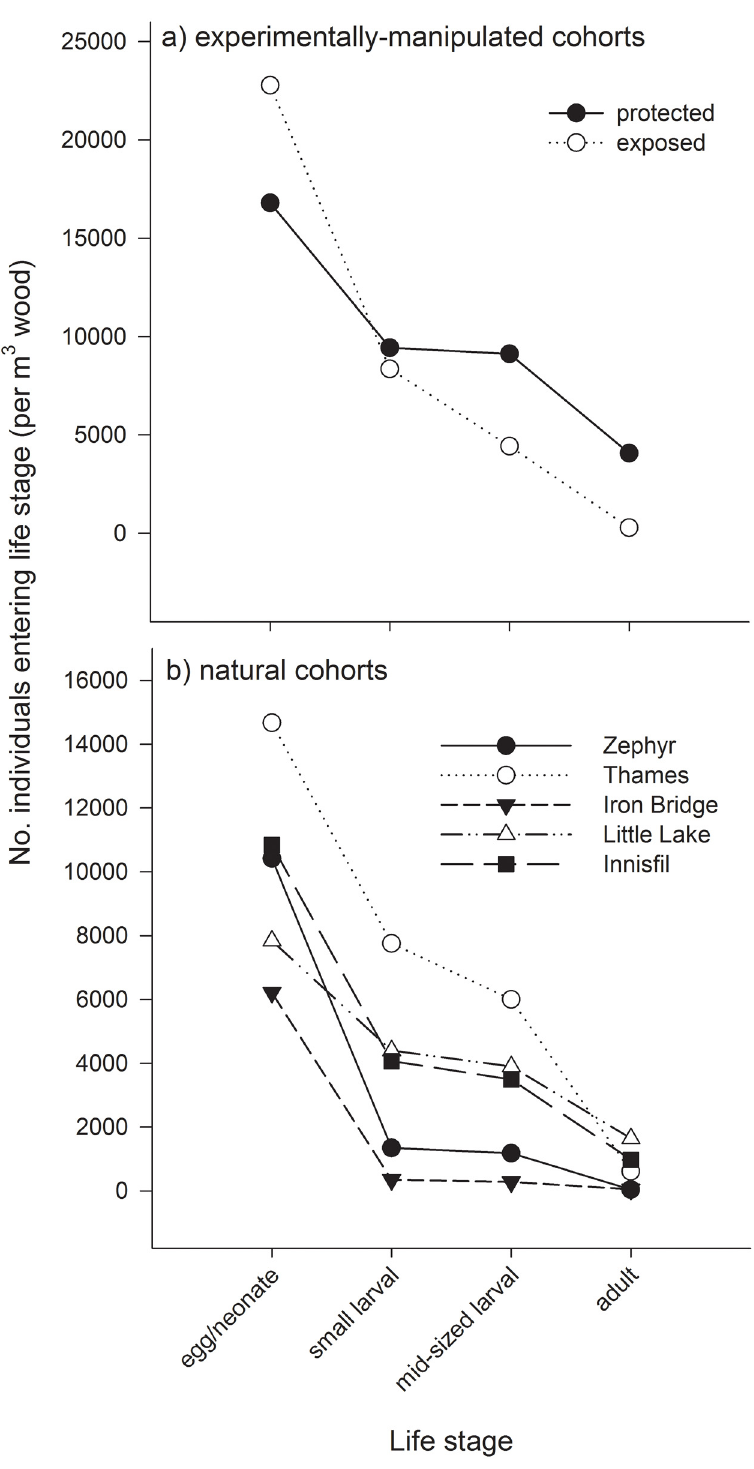
Fig 1. Survivorship curves from (a) experimentally-manipulated and (b) natural Sirex cohorts. Different symbols correspond to different (a) treatments or (b) sites, and represent an estimate of the total population density of Sirex recovered from (a) 9 logs (0.07 m 3 of wood) or (b) one tree (0.006 – 0.21 m 3 of wood each), which were/was collected in October (egg — mid-sized larval stages) or in June (adult stage).